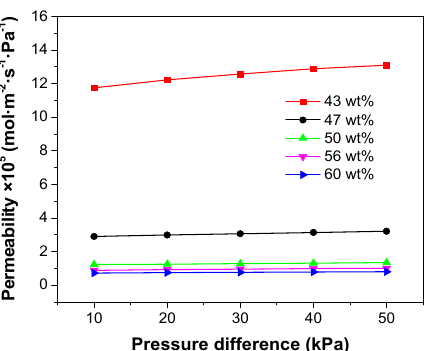
Figure 7. Nitrogen permeability through MgO-CGO supports fabricated from slurries with di ff erent ceramic loadings.